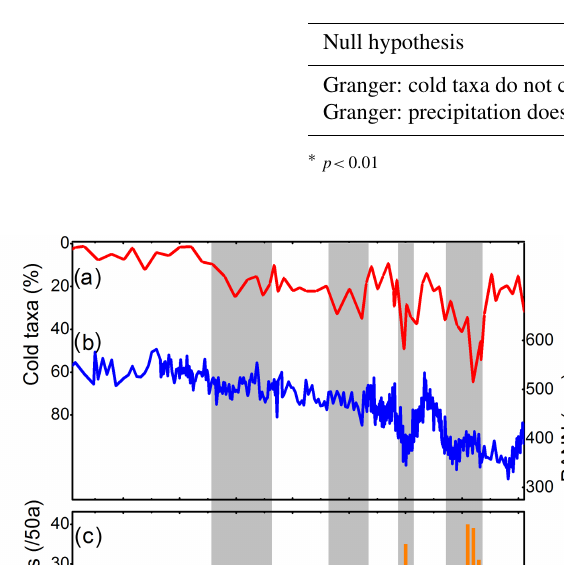
Table 2. Granger causality analysis of cold-preferring chironomid taxa percentages, reconstructed precipitation and incidence of war.